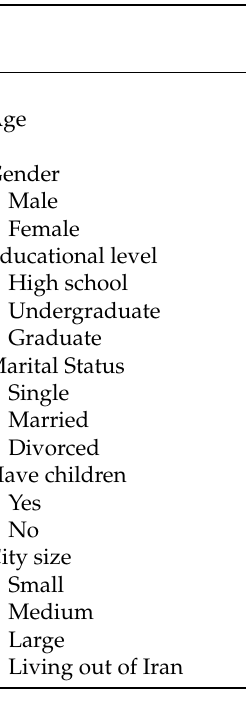
Table 1. Participant